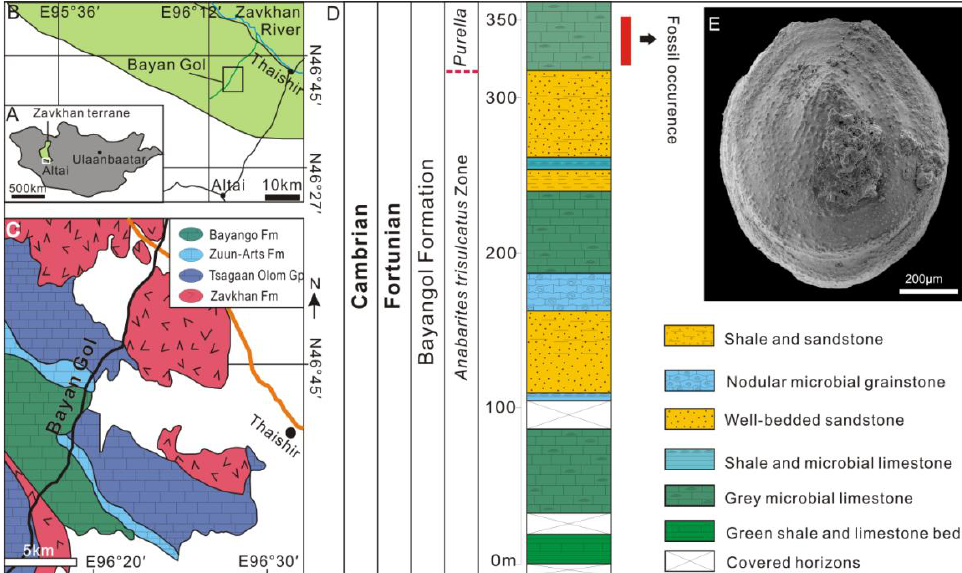
Figure 2. Geological setting, lithostratigraphy, and biostratigraphy. ( A ) Locality map of the Zavkhan terrane, southwestern Mongolia. ( B ) Location of Bayan Gol in the Zavkhan Basin. ( C ) Geological map of Bayan Gol and the location of section BAY2, GPS: 46°42 ′ 11.0 ″ N /96°18 ′ 44.5 ″ E . ( D ) Lithostratigraphic columns of the Bayangol Formation in the BAY2 section and fossil occurrence horizon. The boundary of the small shelly fossil Anabarites trisulcatus Zone and Purella Zone is temporarily placed at 335 m above the base of the section. ( E ) Specimen NRM Mo196855, overall morphology of cap-shaped helcionelloid Postacanthella voronini .